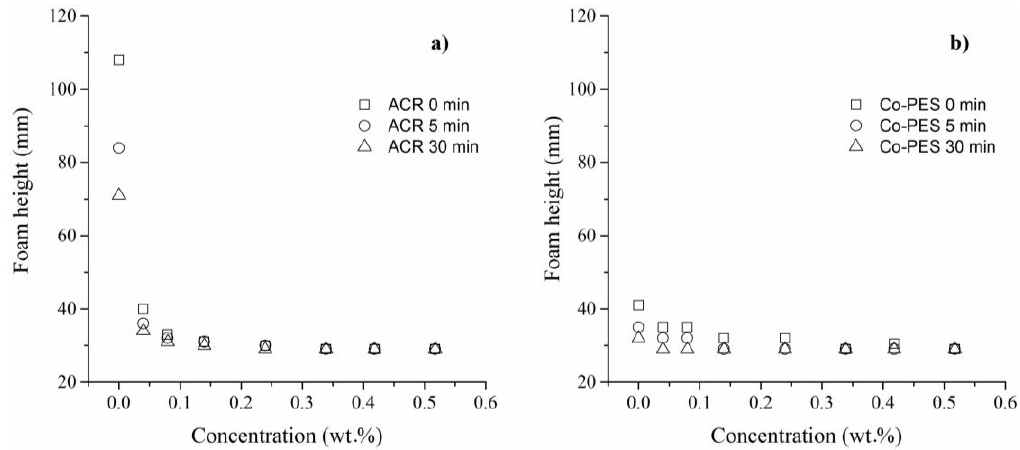
Figure 10. Foam height time dependence of the ACR dispersion ( a ), and Co-PES dispersion ( b ) with different concentrations of the Agent 1.